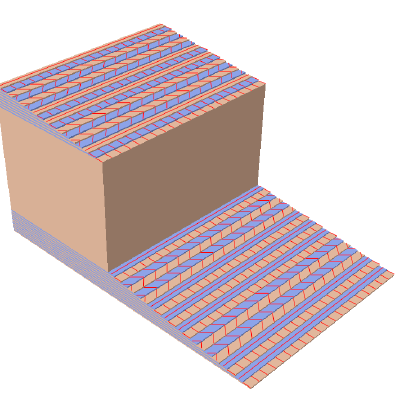
Table 6. Comparison of natural frequencies of the cable-stayed and the beam footbridges with the RC Figure 7. The FE model of GFRP composite sandwich slab with plies of di ff erent fiber orientation. and GFRP slabs, corresponding to basic vertical modes. Figure 7. The FE model of GFRP composite sandwich slab with plies of different fiber orientation.